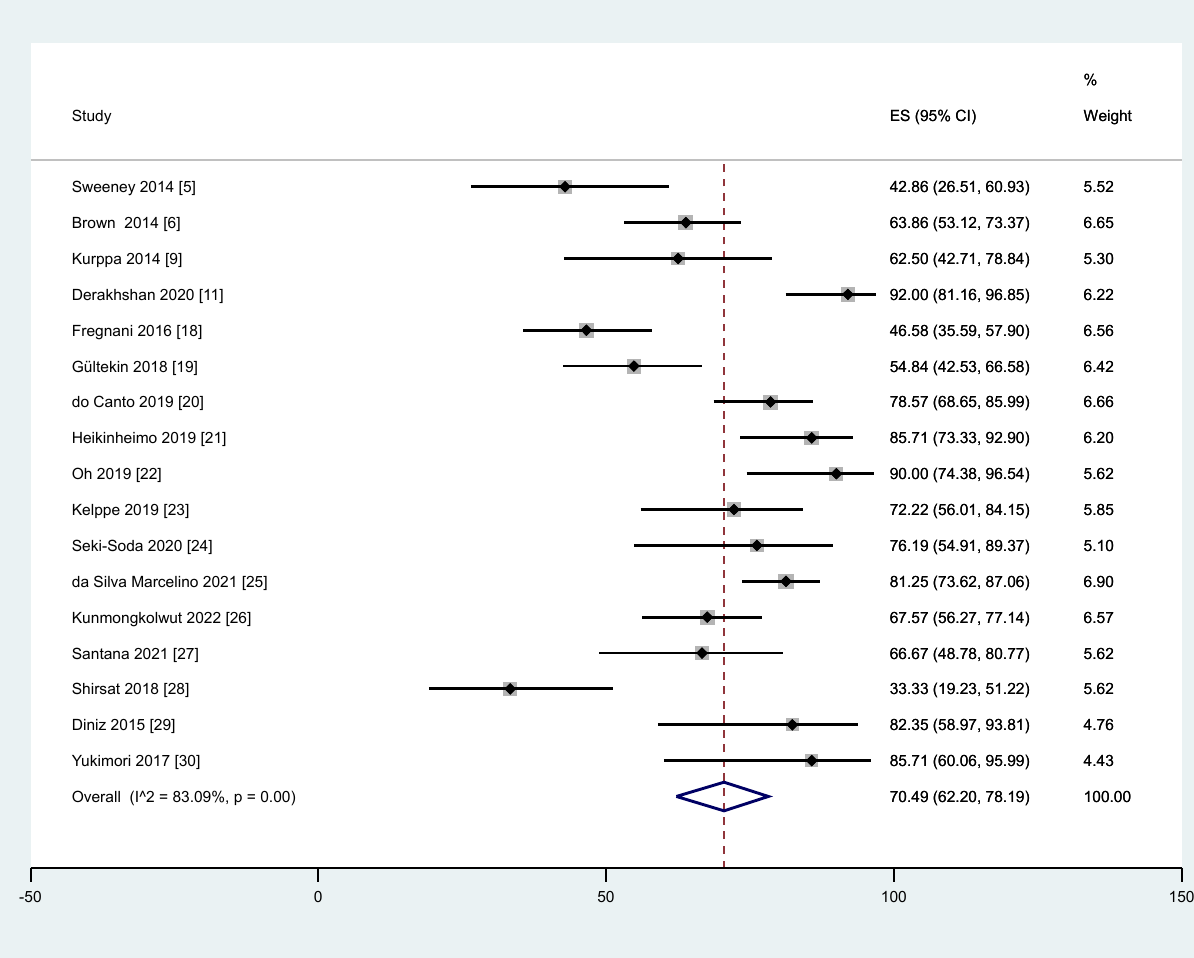
Figure 2. The pooled prevalence of BRAF V600E mutation in ameloblastoma cases.